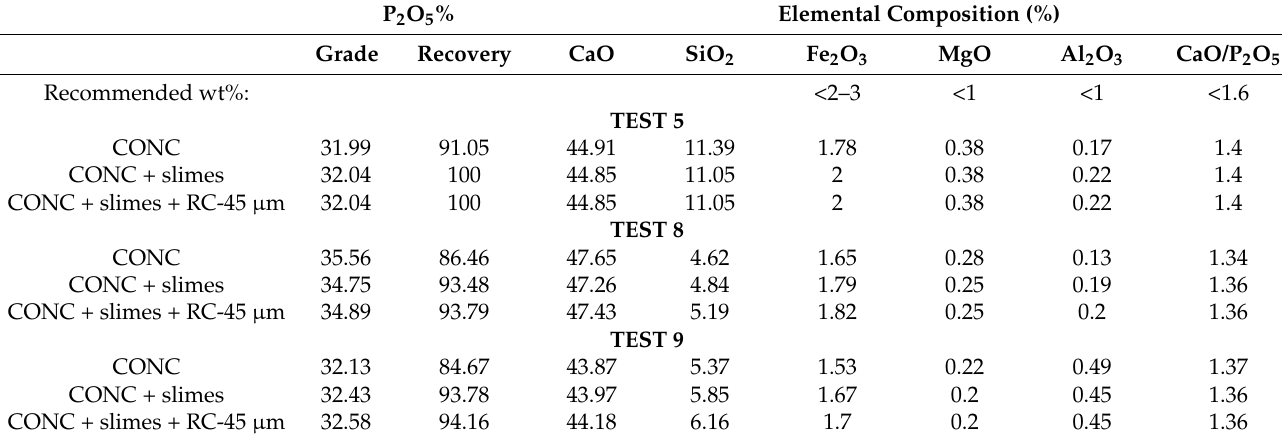
Table 4. Summary of the achieved results for the three selected optimum tests (Tests 5, 8, and